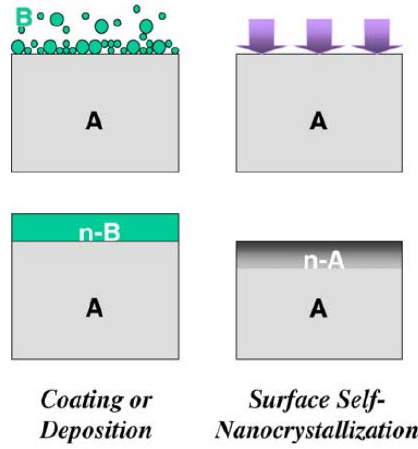
Figure 2. Schematic illustrations of ( A ) surface coating and ( B ) surface nano-crystallization reprinted with permission from Ref. [13]. Copyright 2022, ELSEVIER.